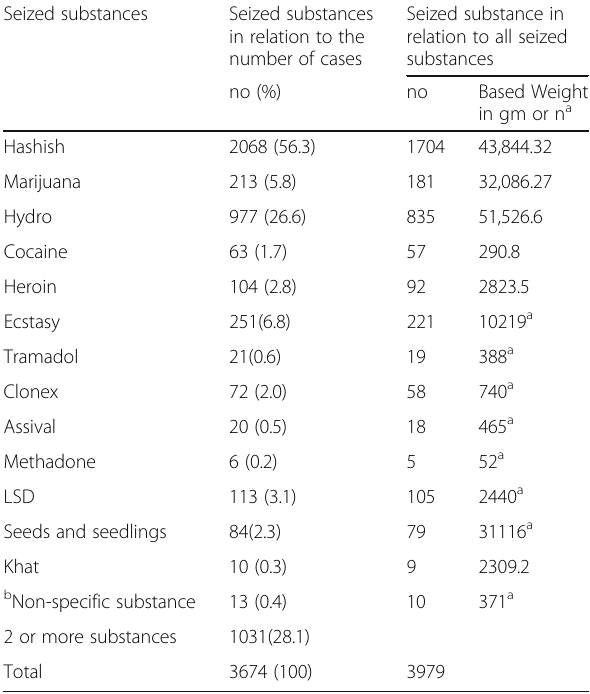
Table 3 Type of possessed substances in relation to the number of cases and in relation to all seized substances in the West Bank across the years 2010 –